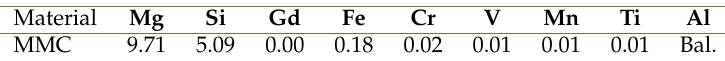
Table 1. Chemical compositions of Al-15%Mg 2 Si ingot (wt. %)